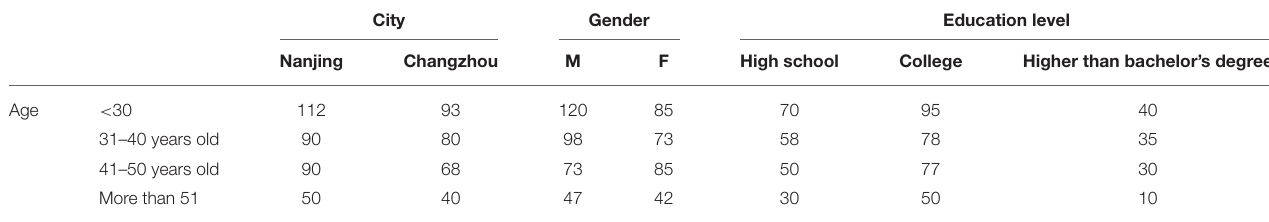
TABLE 1 | Descriptive analysis of samples.